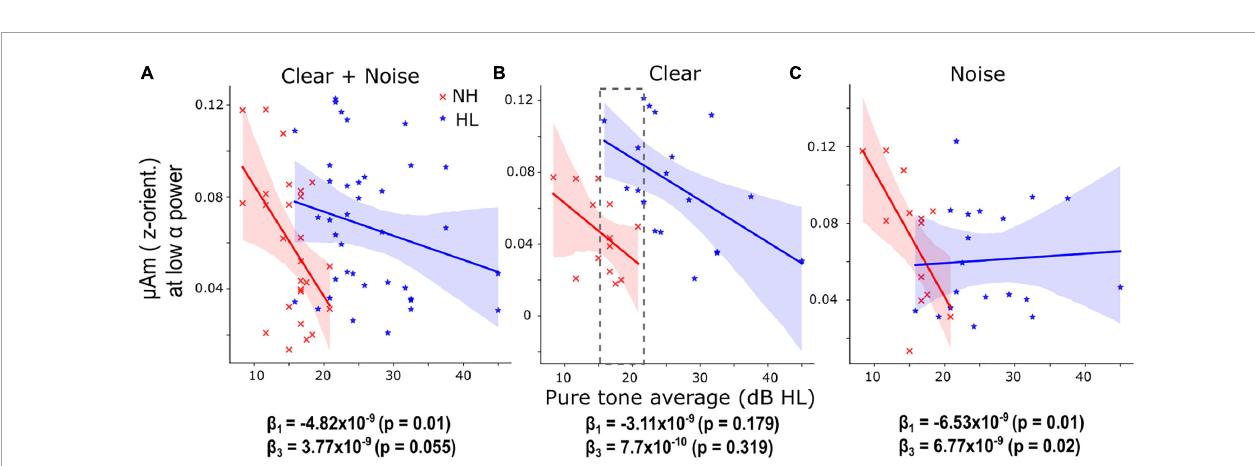
FIGURE4 Hearing loss is associated with smaller speech-frequency-following responses (FFR) amplitude under low cortical α (i.e., high arousal) states. (A) When pooling SNRs, the decrease (slope) of low α FFR F0 amplitudes as a function of pure-tone averages (PTA) in the NH group was significant ( β 1 = –4.82 × 10 − 9 , p = 0.01) and the slope of the HL group was not significantly different from the normal-hearing (NH) group. (B) For clear speech, similar trends of low α FFR amplitudes decreased with increased PTA were observed in the NH and HL groups though the slopes were not significant. The gray dashed box marks the overlapping PTA region for both groups. (C) For noise-degraded speech, the slope of low α FFR amplitudes decreased with increased PTA was significant ( β 1 = –6.53 × 10 − 9 , p = 0.01) in the NH group and the slope of the HL group was significantly different ( β 3 = 6.77 × 10 − 9 , p = 0.02) from the NH group. The fitted regression lines showed that low α FFR amplitudes were generally diminished by noise in the HL group. Shaded area = 95% CI of the regression